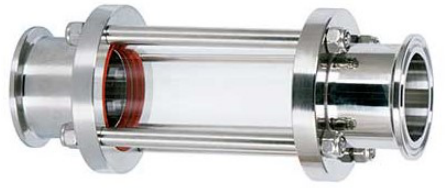
Figure 4. Photo of the sight glasses used in the